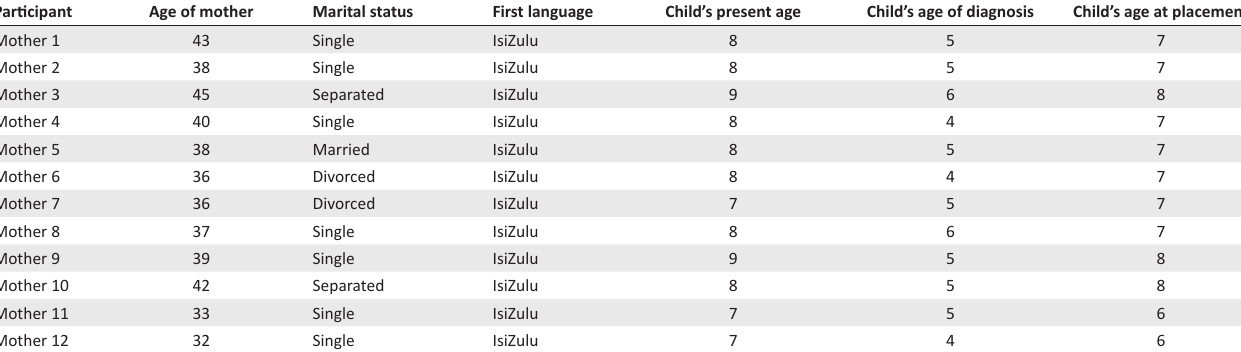
TABLE 1: Profile of the